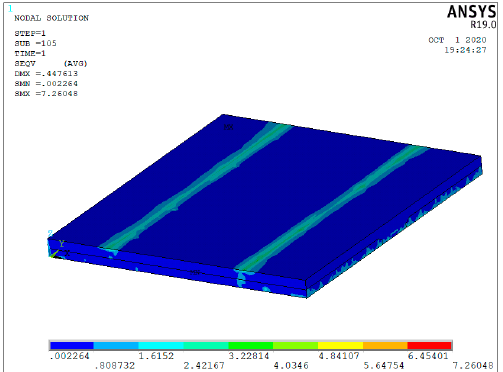
Figure 28. Equivalent stress cloud diagram of the CLHCPCS under ultimate load.